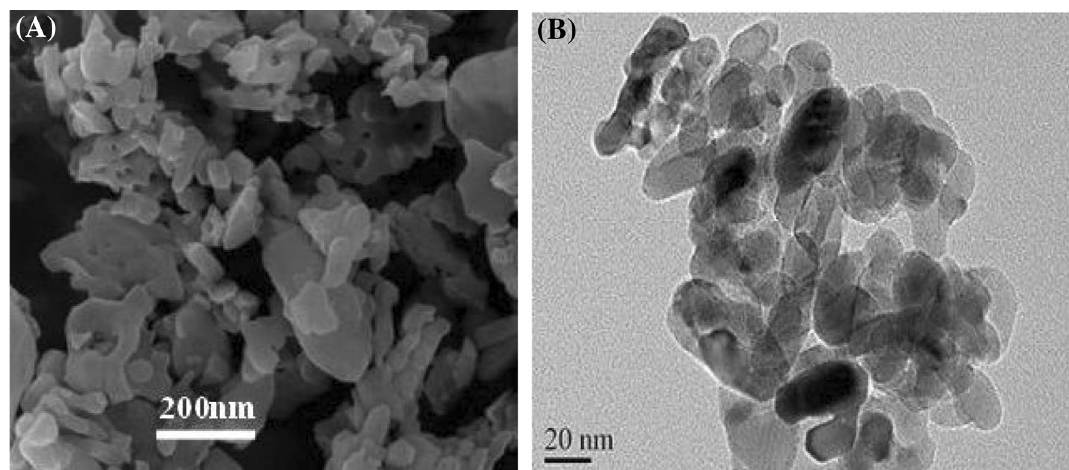
Figure 2. TEM images of (A) TiO 2 , (B) Al 2 O 3 nanoparticles.